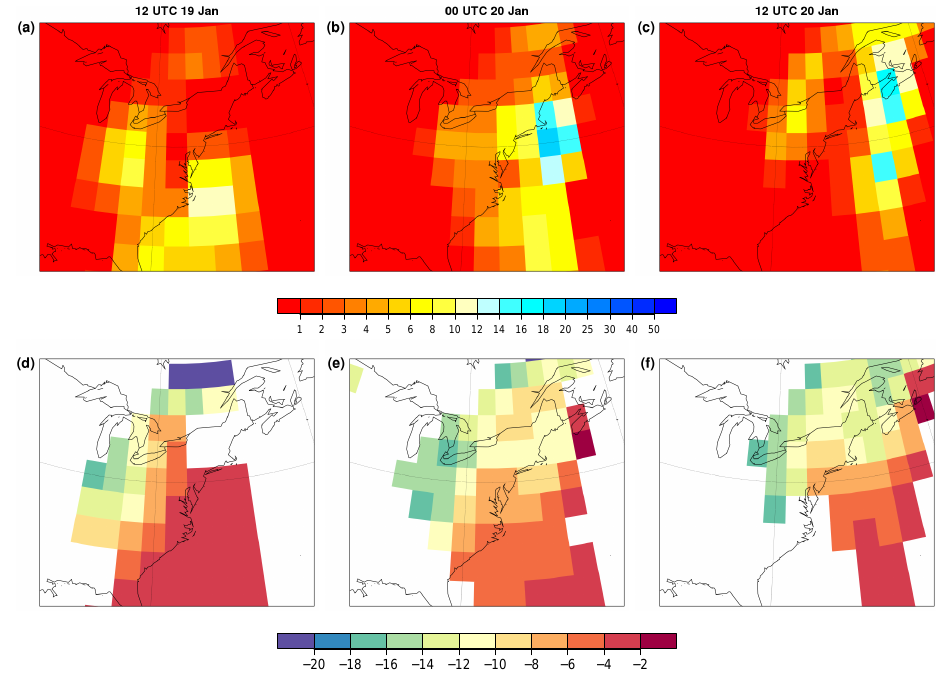
Fig. 8. (a–c) Precipitation rate (in mm per 6 hours) and (d–f) the corresponding δ 18 O from the IsoGSM simulation at (a, d) 12:00UTC 19 January, (b, e) 00:00UTC 20 January and (c, f) 12:00UTC 20 January. Isotope data are only shown where the simulated precipitation rate is larger than 0.6mm per 6